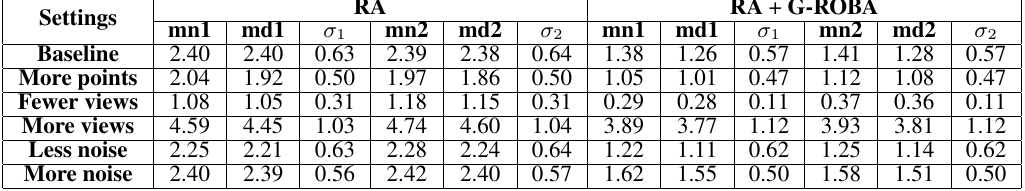
Table 1: Results of the closed-loop simulation. The metrics, mn/md/ σ /1/2: mean/median angular error (in degrees) after the L 1 / L 2 alignment, respectively. For all settings, the RA + G-ROBA improves the results of the RA. RA Settings